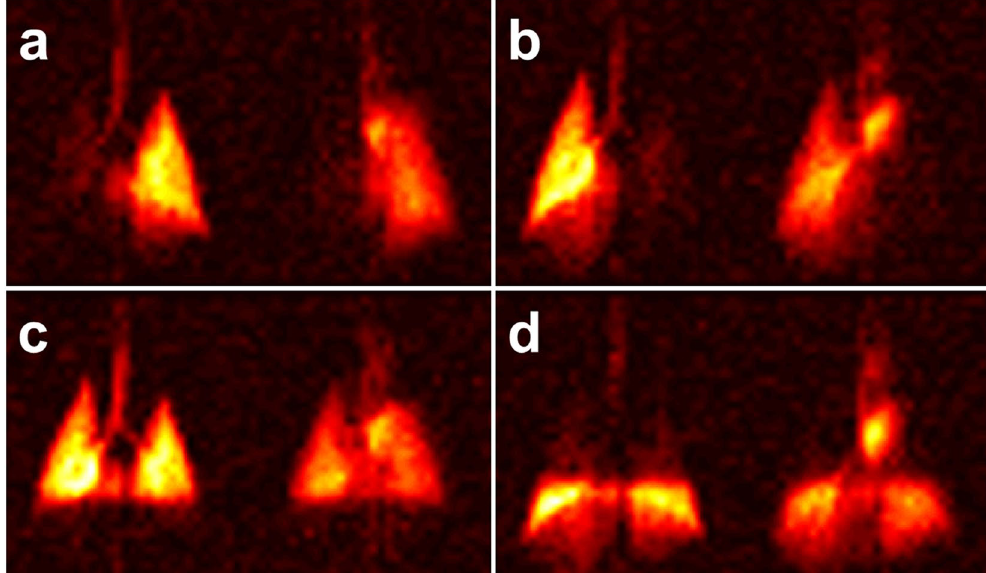
Figure 5. Xenon GP and DP maps for a DP flip angle of 40° and a TR of 200 ms following saturation of the GP signal in the ( a ) right, ( b ) left, ( c ) inferior and ( d ) superior lung. The signal changes in the DP maps relative to an unsaturated baseline map, particularly in a far downstream location such as the heart, reflect the contributions of the saturated lung volume to total lung function.